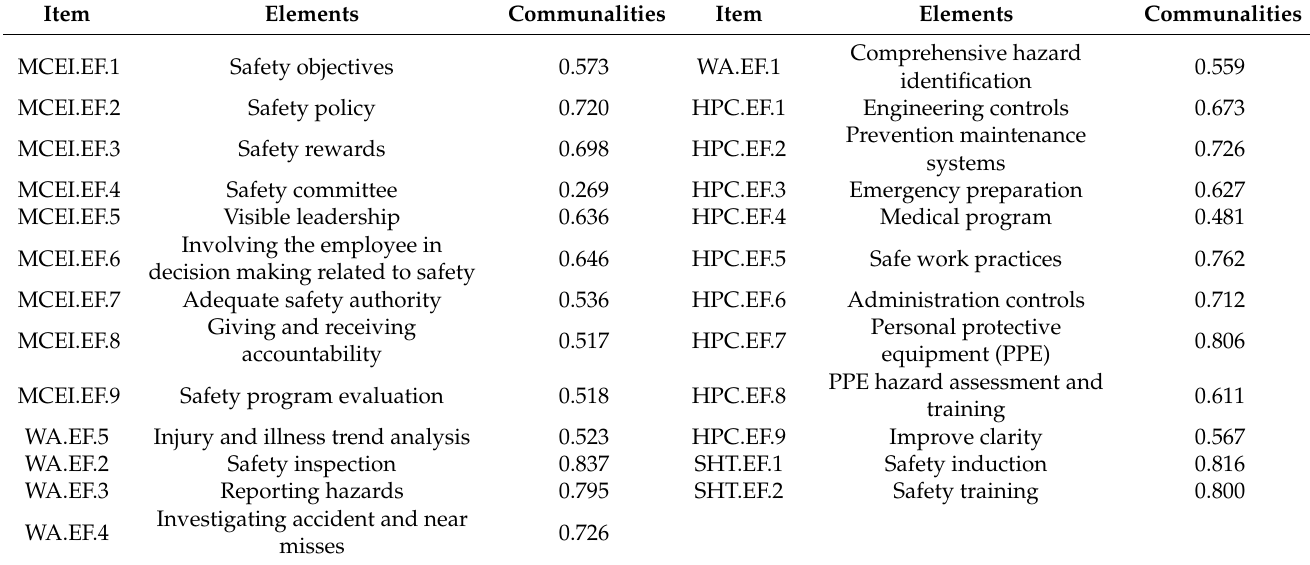
Table 4. The communalities of 25 safety program elements.